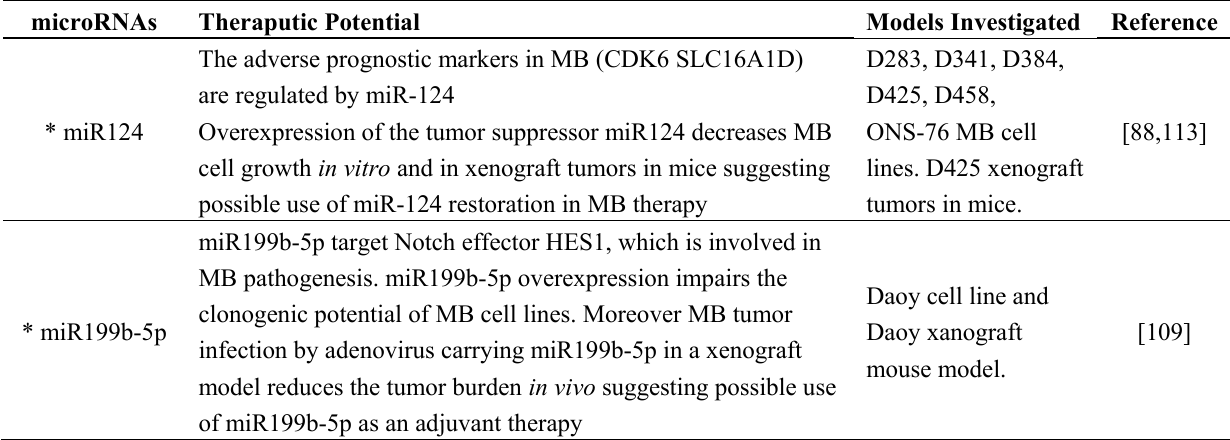
Table 4. Example of preclinical functional studies of miRNAs in MB and NB [235].